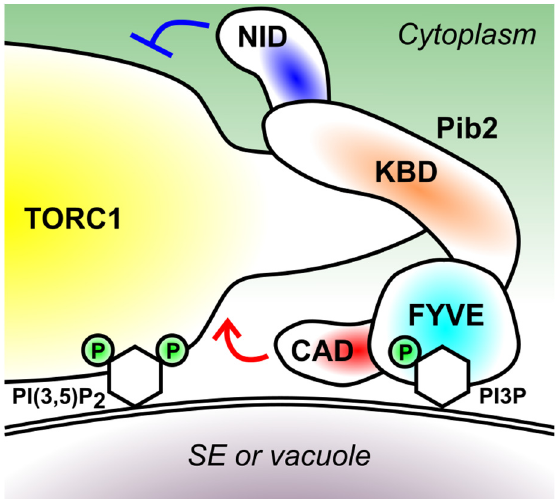
Figure 3. The domain structure of Pib2 and a model of its membrane recruitment. Pib2 is recruited to the surface of signaling endosomes (SE) and vacuoles via the interaction between its FYVE domain and the membrane lipid PI3P. The KBD domain mediates the interaction with the Kog1 subunit of TORC1, which in turn interacts with the membrane lipid PI(3,5)P 2 . ‘P’ denotes phosphorylation on the inositol rings (depicted as hexagons) of PI3P and PI(3,5)P 2 . The CAD and NID domain of Pib2 activates and inhibits TORC1, respectively.